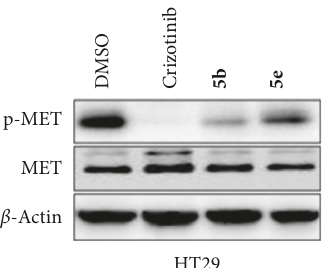
Figure 3: Effect of Crizotinib and the target compounds on MET activity in HT29 cancer Table 3: Molecular properties and drug-likeness. Compound